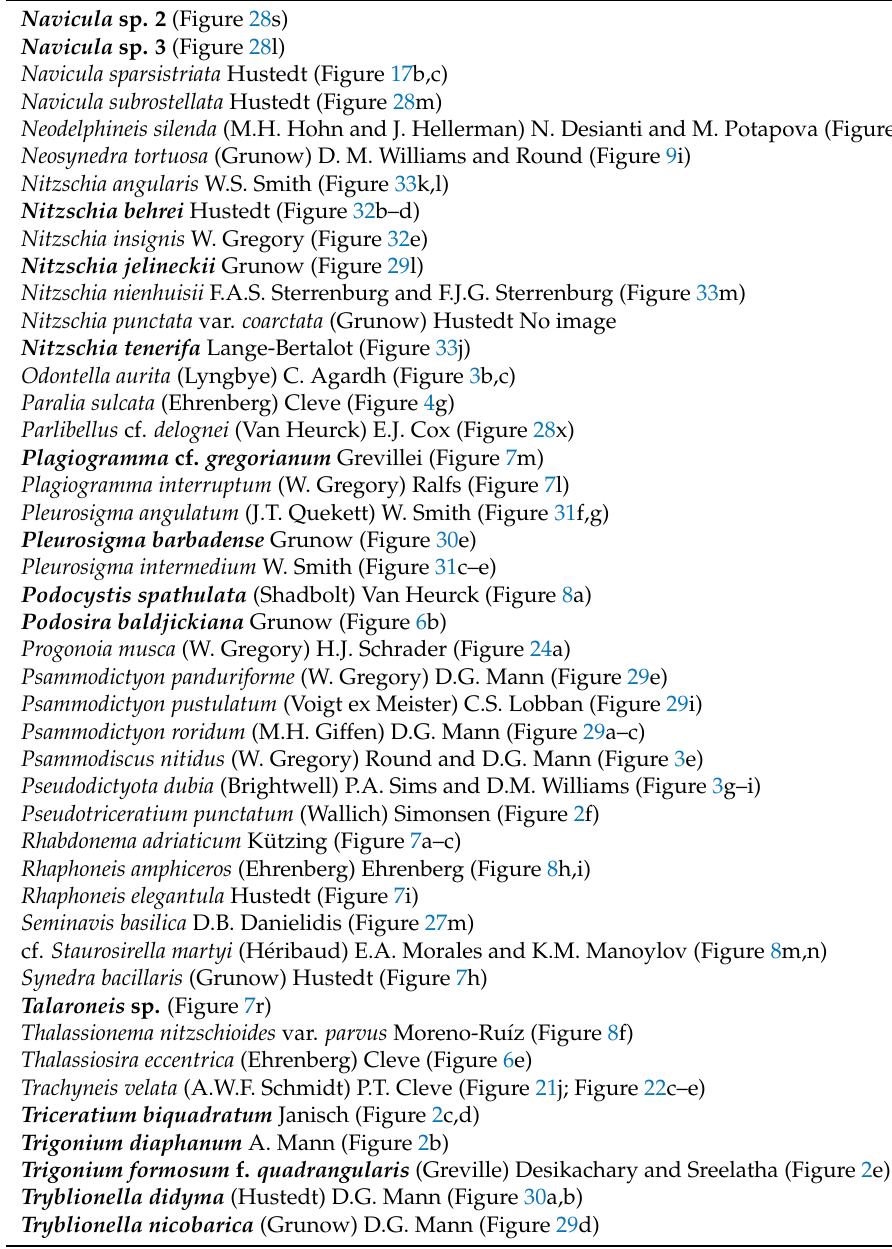
Table 1. Cont. Navicula sp. 2 (Figure 28s) Navicula sp. 3 (Figure 28l) Navicula sparsistriata Hustedt (Figure 17b,c) Navicula subrostellata Hustedt (Figure 28m) Neodelphineis silenda (M.H. Hohn and J. Hellerman) N. Desianti and M. Potapova (Figure 8l) Neosynedra tortuosa (Grunow) D. M. Williams and Round (Figure 9i) Nitzschia angularis W.S. Smith (Figure 33k,l) Nitzschia behrei Hustedt (Figure 32b–d) Nitzschia insignis W. Gregory (Figure 32e) Nitzschia jelineckii Grunow (Figure 29l) Nitzschia nienhuisii F.A.S. Sterrenburg and F.J.G. Sterrenburg (Figure 33m) Nitzschia punctata var. coarctata (Grunow) Hustedt No image Nitzschia tenerifa Lange-Bertalot (Figure 33j) Odontella aurita (Lyngbye) C. Agardh (Figure 3b,c) Paralia sulcata (Ehrenberg) Cleve (Figure 4g) Parlibellus cf. delognei (Van Heurck) E.J. Cox (Figure 28x) Plagiogramma cf. gregorianum Grevillei (Figure 7m) Plagiogramma interruptum (W. Gregory) Ralfs (Figure 7l) Pleurosigma angulatum (J.T. Quekett) W. Smith (Figure 31f,g) Pleurosigma barbadense Grunow (Figure 30e) Pleurosigma intermedium W. Smith (Figure 31c–e) Podocystis spathulata (Shadbolt) Van Heurck (Figure 8a) Podosira baldjickiana Grunow (Figure 6b) Progonoia musca (W. Gregory) H.J. Schrader (Figure 24a) Psammodictyon panduriforme (W. Gregory) D.G. Mann (Figure 29e) Psammodictyon pustulatum (Voigt ex Meister) C.S. Lobban (Figure 29i) Psammodictyon roridum (M.H. Giffen) D.G. Mann (Figure 29a–c) Psammodiscus nitidus (W. Gregory) Round and D.G. Mann (Figure 3e) Pseudodictyota dubia (Brightwell) P.A. Sims and D.M. Williams (Figure 3g–i) Pseudotriceratium punctatum (Wallich) Simonsen (Figure 2f) Rhabdonema adriaticum Kützing (Figure 7a–c) Rhaphoneis amphiceros (Ehrenberg) Ehrenberg (Figure 8h,i) Rhaphoneis elegantula Hustedt (Figure 7i) Seminavis basilica D.B. Danielidis (Figure 27m) cf. Staurosirella martyi (H é ribaud) E.A. Morales and K.M. Manoylov (Figure 8m,n) Synedra bacillaris (Grunow) Hustedt (Figure 7h) Talaroneis sp. (Figure 7r) Thalassionema nitzschioides var. parvus Moreno-Ru í z (Figure 8f) Thalassiosira eccentrica (Ehrenberg) Cleve (Figure 6e) Trachyneis velata (A.W.F. Schmidt) P.T. Cleve (Figure 21j; Figure 22c–e) Triceratium biquadratum Janisch (Figure 2c,d) Trigonium diaphanum A. Mann (Figure 2b) Trigonium formosum f. quadrangularis (Greville) Desikachary and Sreelatha (Figure 2e) Tryblionella didyma (Hustedt) D.G. Mann (Figure 30a,b) Tryblionella nicobarica (Grunow) D.G. Mann (Figure